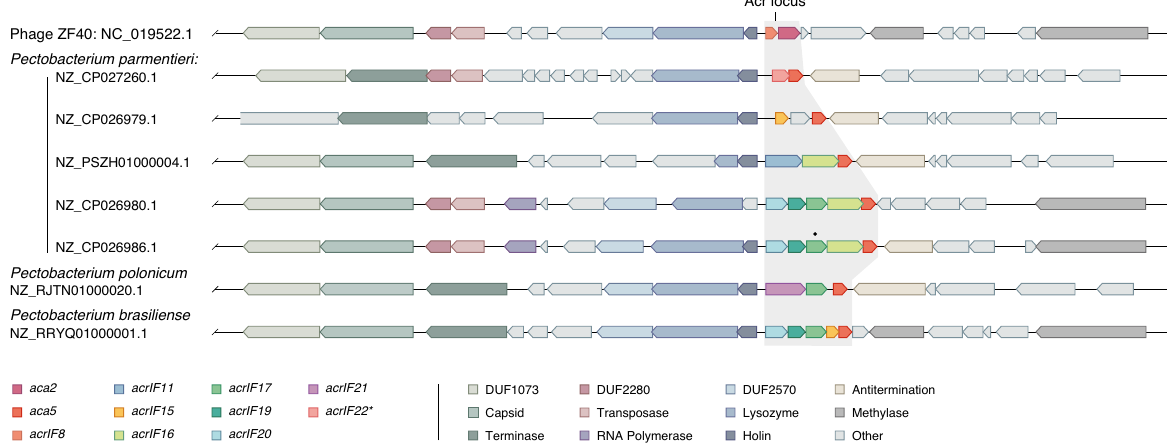
Fig. 3 Genomic comparison between Pectobacterium phage ZF40 and different Pectobacterium genomes with related prophage regions. The alignment of the acr loci in related prophages/MGEs shows variability in nearby genes. Genes are color-coded according to their functional annotations. Gene annotations are based on protein sequence searches against pfam and pVOG (Supplementary Data 5). The black dot denotes a pseudogene (early stop codon); domain of unknown function